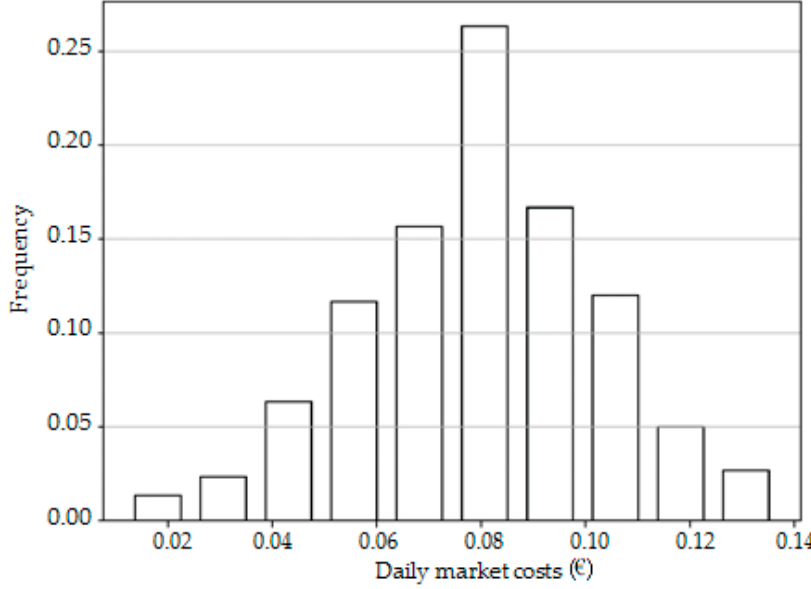
Figure 9. The histogram of the estimated total daily costs for the distributed market. This is the sum of the fees paid by the market operators for offer placement and of the fees paid by the SO for the solving of the market.